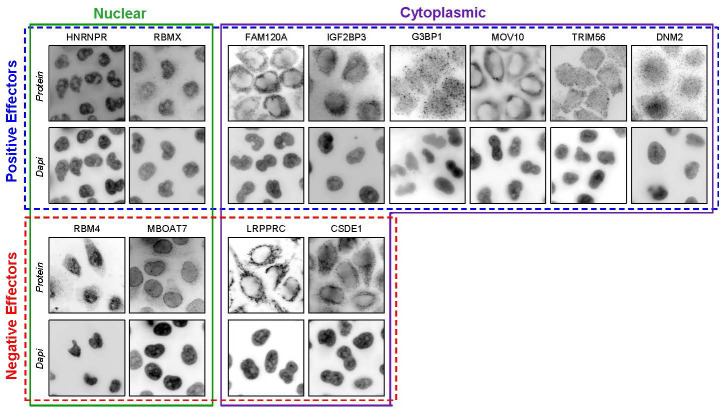
Representative images of host protein general cellular localization.Uninfected HeLa cells were treated with host protein specific antibodies and DAPI for immunofluorescence detection. Host protein images are organized by general primary cellular localization and the siRNA knockdown determined effect that host protein has on HIV gene expression. MBOAT7 has a prominent peri-nuclear localization that has not been definitively shown to be inside or outside of the nucleus. This protein appears to localize in both the nucleus and cytoplasm but is grouped as a nuclear protein here.